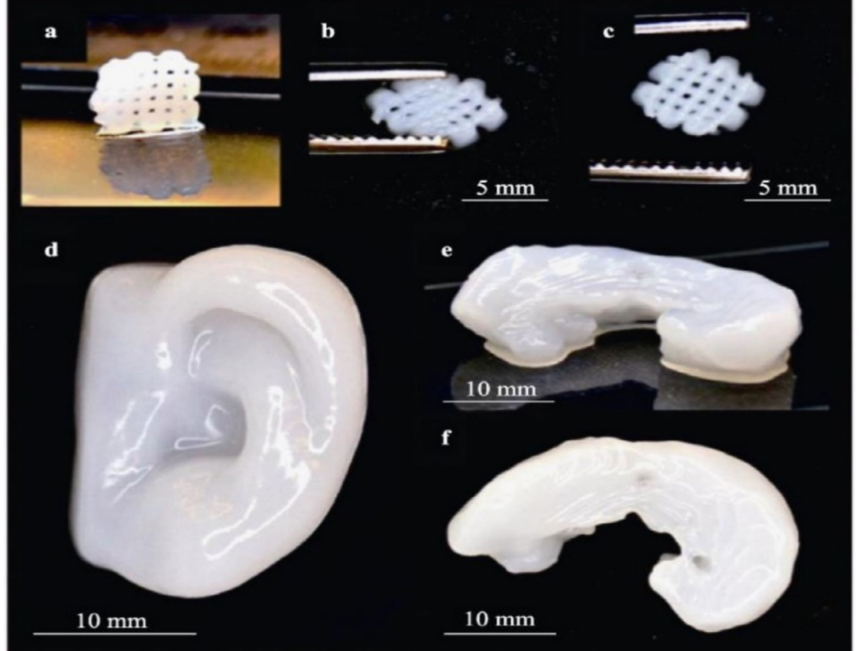
Figure 8. ( a ) 3D printed small grids (7.2 mm × 7.2 mm) with Ink 8020 after cross-linking; ( b ) shape of grid deforms while squeezing; and ( c ) it is restored after squeezing. ( d ) 3D printed human ear and ( e , f ) sheep meniscus with Ink 8020. Side view ( e ) and top view ( f ) of meniscus